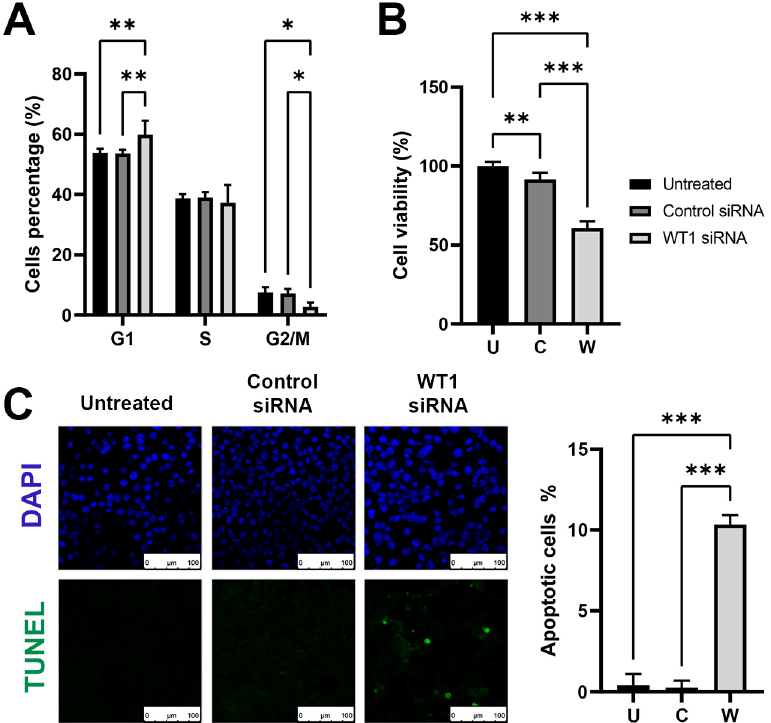
Figure 2. Induction of cell cycle arrest decreased viability and apoptosis activation after WT1 silencing on melanoma cells. ( A ) WT1 silencing induces G1 cell cycle arrest and decreased G2/M progression measured via PI cytometry. ( B ) AlamarBlue assay shows a reduced viability in the group treated with WT1 siRNA. ( C ) Apoptosis detection via a TUNEL assay after WT1 silencing using fluorescent microscopy. The graph shows the percentage of TUNEL-positive nuclei per field compared to the untreated group. All experiments were performed after 72 h of treatment. Groups U: Untreated, C: Control siRNA, W: WT1 siRNA. Scale bars represent 100 µm. One-way ANOVA was used as statistical test for group’s comparison. * p < 0.05, ** p < 0.01, *** p < 0.001.